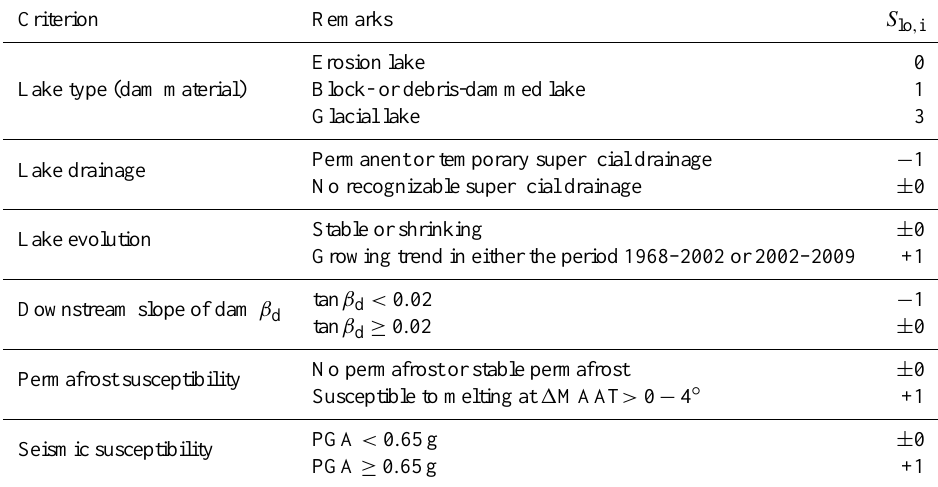
Table 7. Scoring scheme for susceptibility to lake outburst triggered by internal factors S lo . The initial values of S lo are determined from the dam material, these values are then increased or decreased according to lake drainage, lake evolution, downstream slope of dam, permafrost susceptibility and seismic susceptibility.